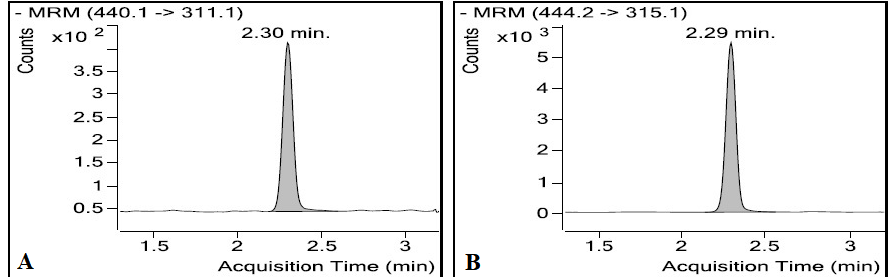
Figure 4. Representative chromatograms of a plasma sample (t = 5 h) from a healthy subject in a bioavailability study showing ( A ) folic acid and ( B ) I.S.